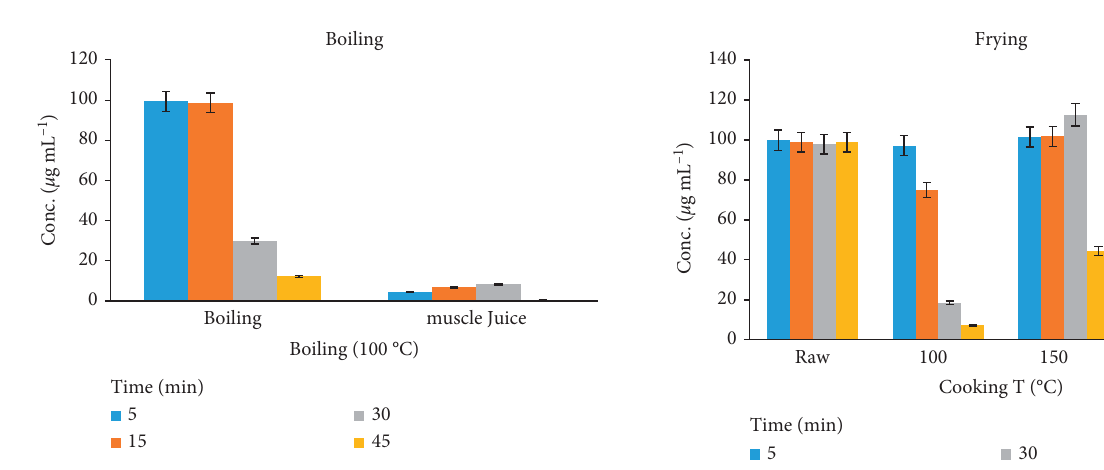
Figure 4: The effects of boiling on the depletion of Amox residue within different time periods from chicken tissue. Figure